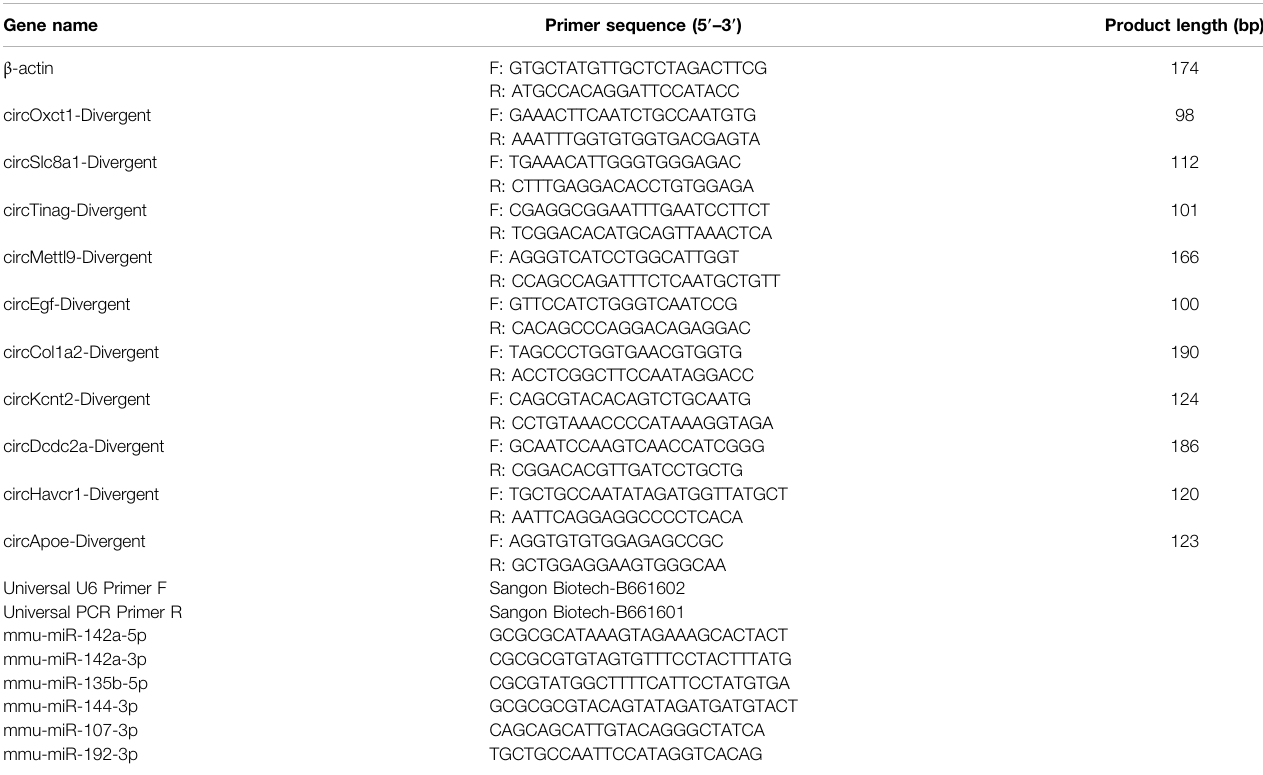
TABLE 1 | Primer sequences in this